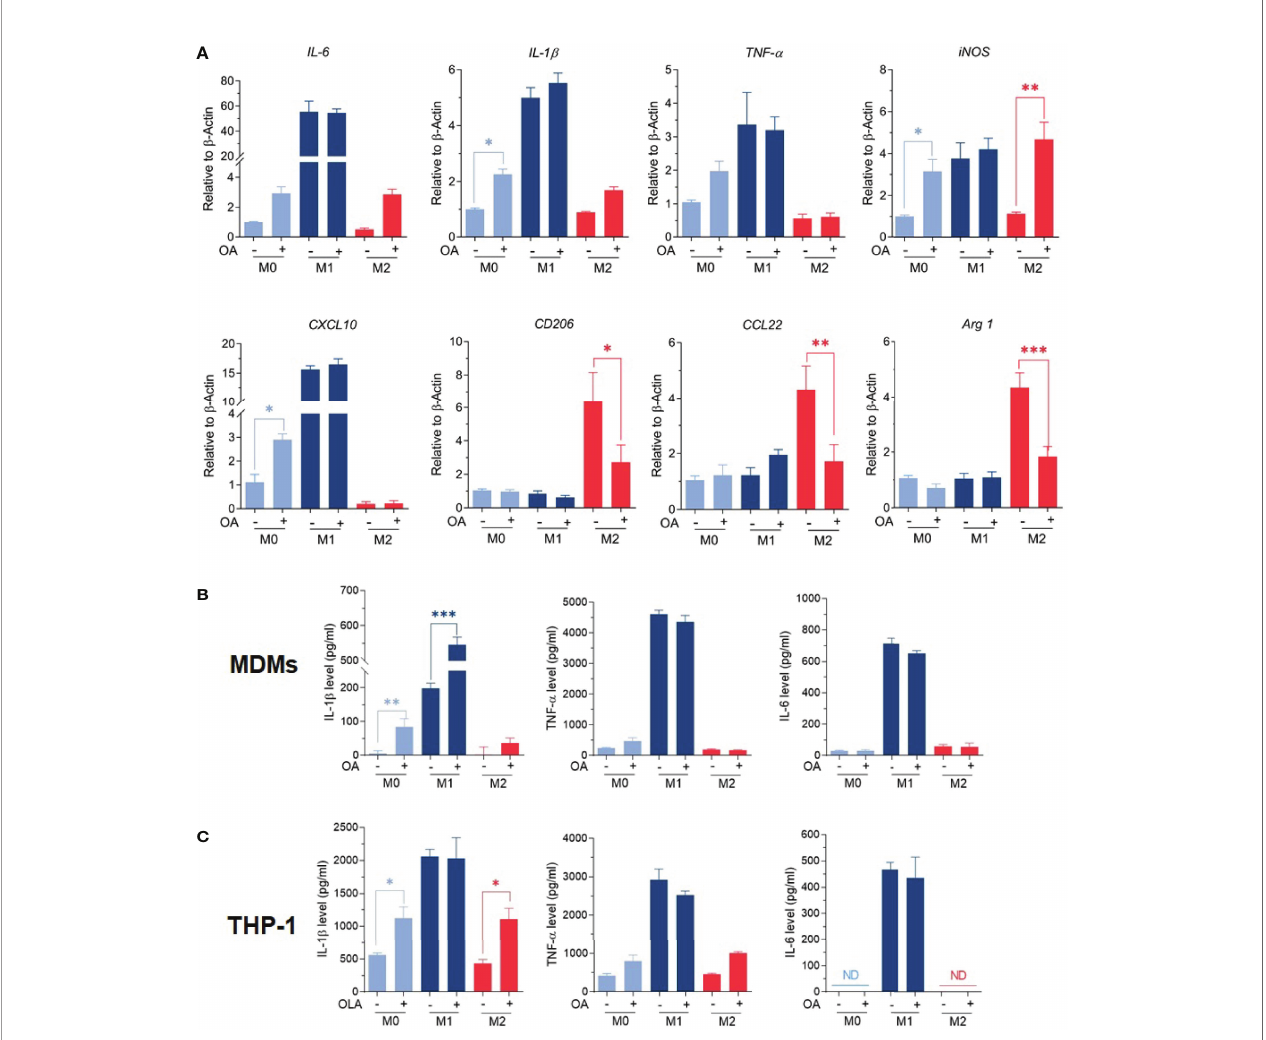
FIGURE 3 | Oleamide mediated M1 macrophage polarization. (A) M1/M2 gene expression by RT-qPCR. (B, C) Cytokine levels by ELISA. MDMs (Day 6) or differentiated THP-1 were cultured in complete medium only (M0), LPS + INF- g (M1), or IL-4 (M2) in the presence or absence of oleamide (15 µg/ml) for 24h in all experiments. One-way ANOVA was performed with multiple comparison corrections (Dunnett test). Data represent the mean ± SEM of three independent experiments. (*p < 0.05, **p < 0.01, ***p <